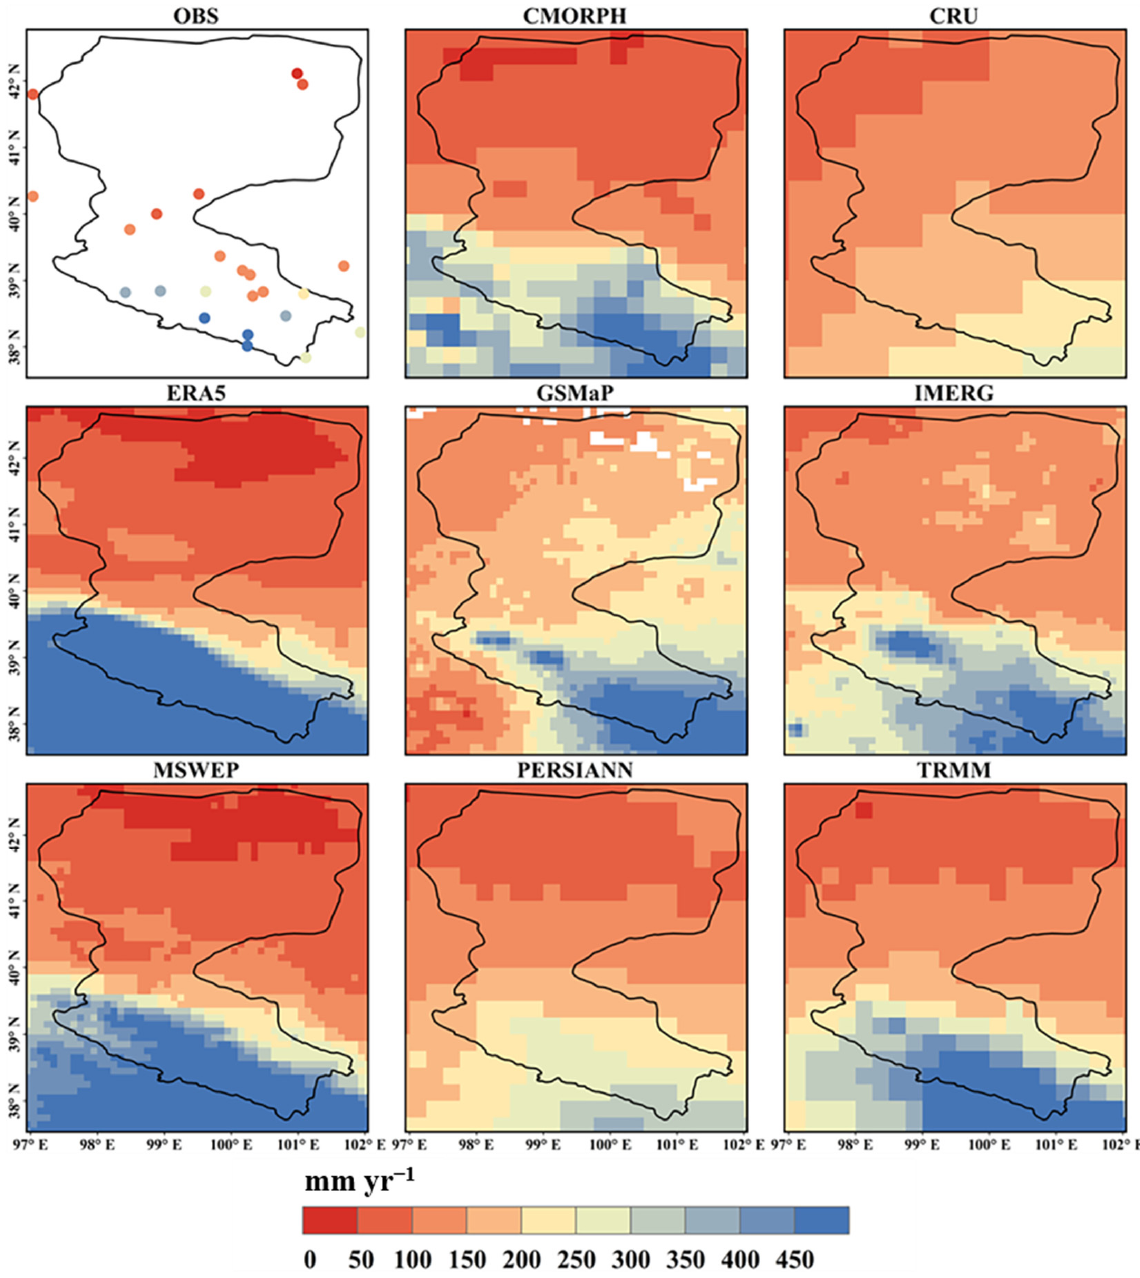
Figure 3. Spatial distribution of annual mean precipitation observations at stations and estimates from each product over the HRB during 2016–2019.